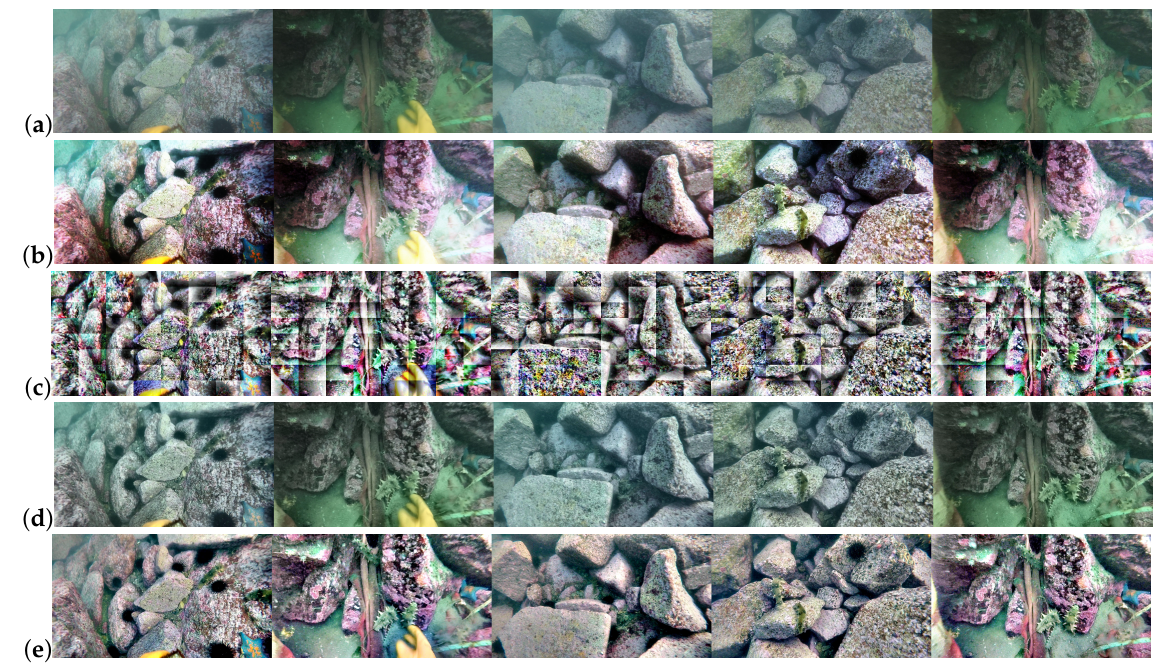
Figure 5. Comparison of underwater image enhancement results for different algorithms: ( a ) original images; ( b ) HE; ( c ) AHE; ( d ) CLAHE; ( e ) MSRCR.